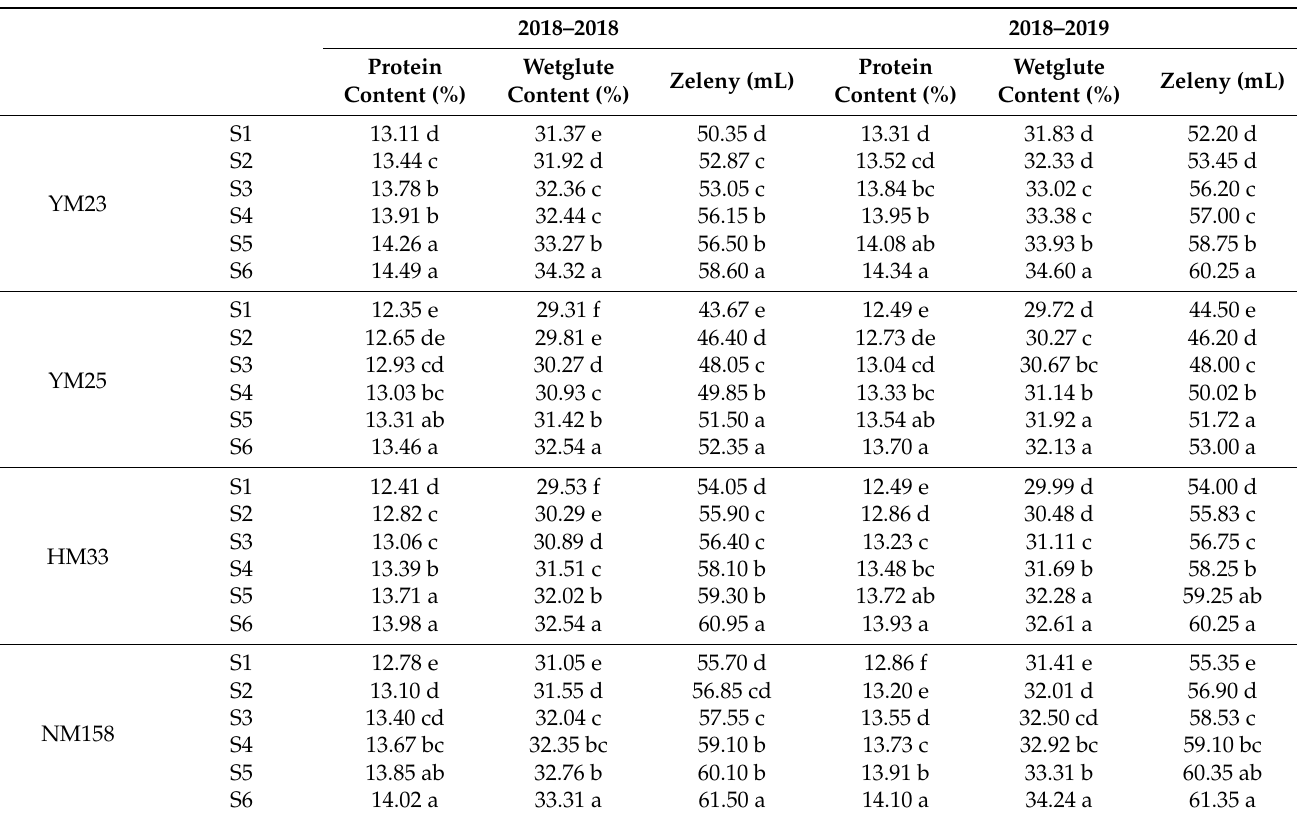
Table 4. Effects of temperature and radiation on protein and related quality of